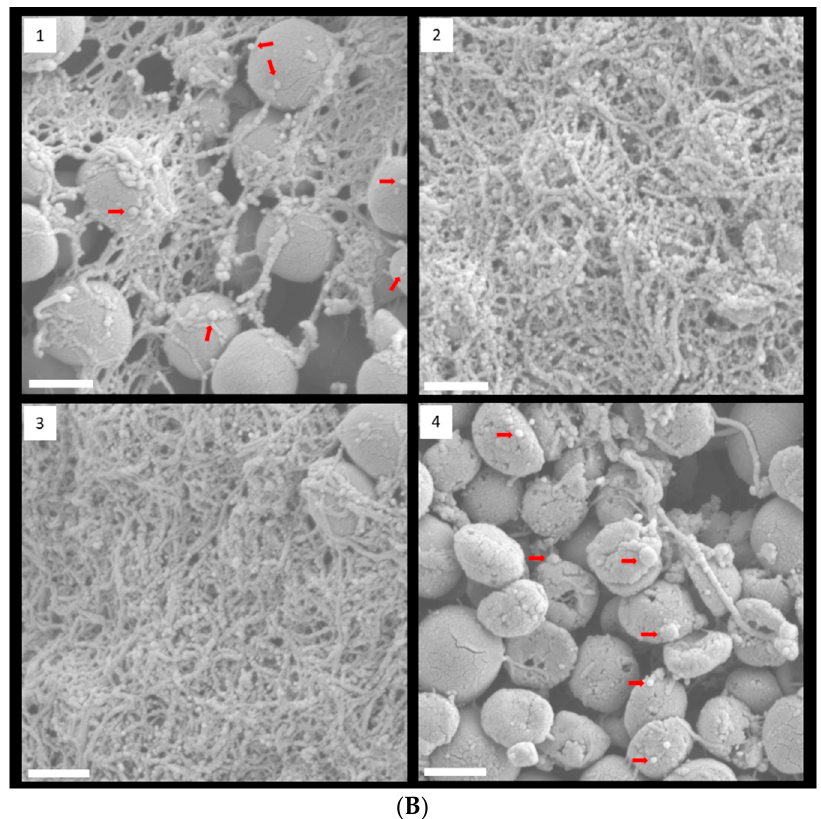
Figure 4. FESEM images of S. epidermidis strain RP62A biofilms. The scale bar in all the images corresponds to 200 µm ( A ) and 0.5 µm ( B ). Arrows indicate membrane vesicles. ( 1 ): Control, ( 2 ): 1/8 MIC, ( 3 ): 1/4 MIC, ( 4 ): 1/2 MIC.